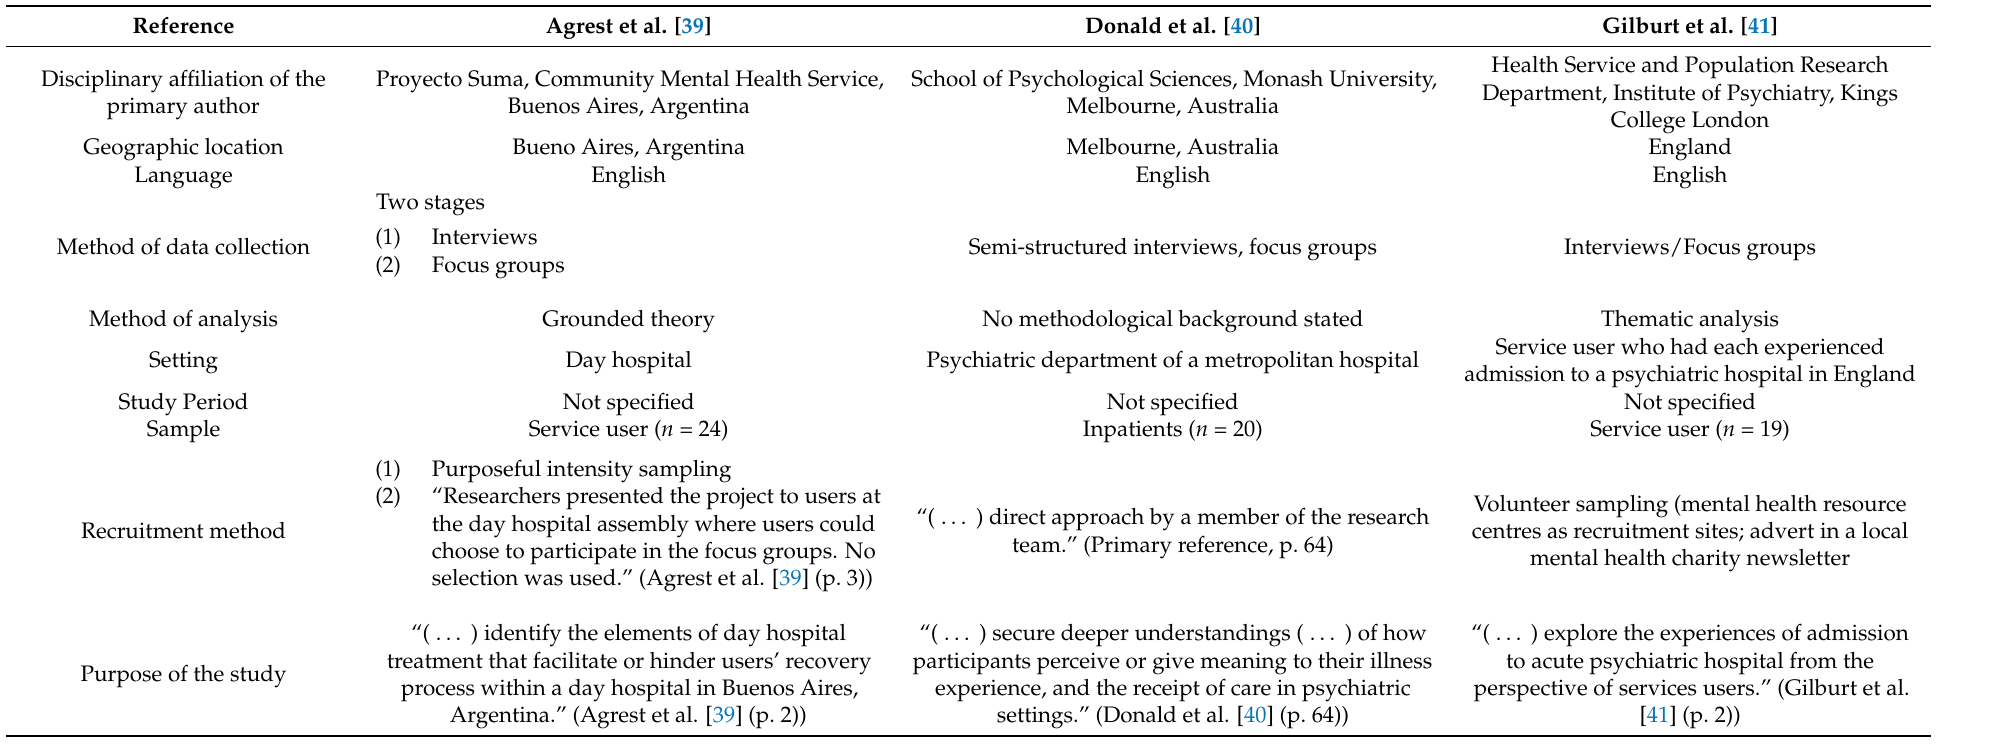
Table 3. Characteristics of the